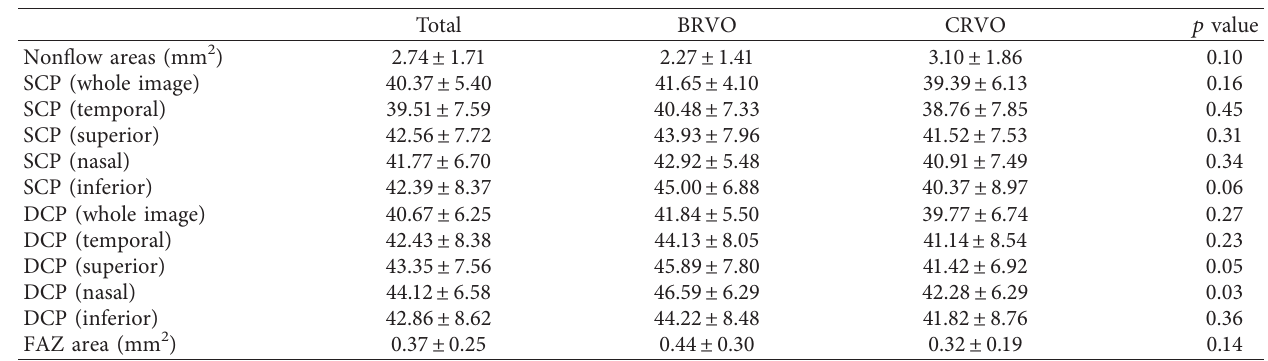
Table 3: OCTA parameters of RVO.